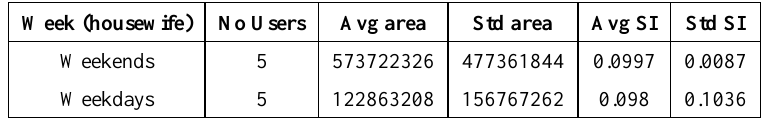
Table 17. Average and standard deviation of area and shape index of housewife users grouped based on